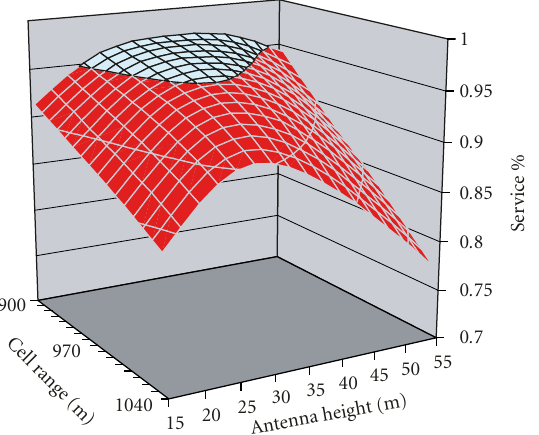
Figure 4: The service probability as a function of antenna height and cell range, and the 95% service probability level.